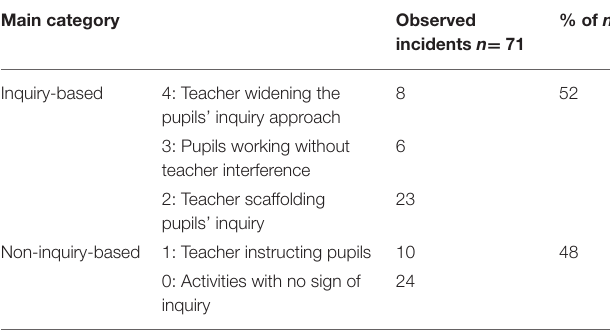
TABLE 3 | Portion of incidents coded as inquiry-based, n =